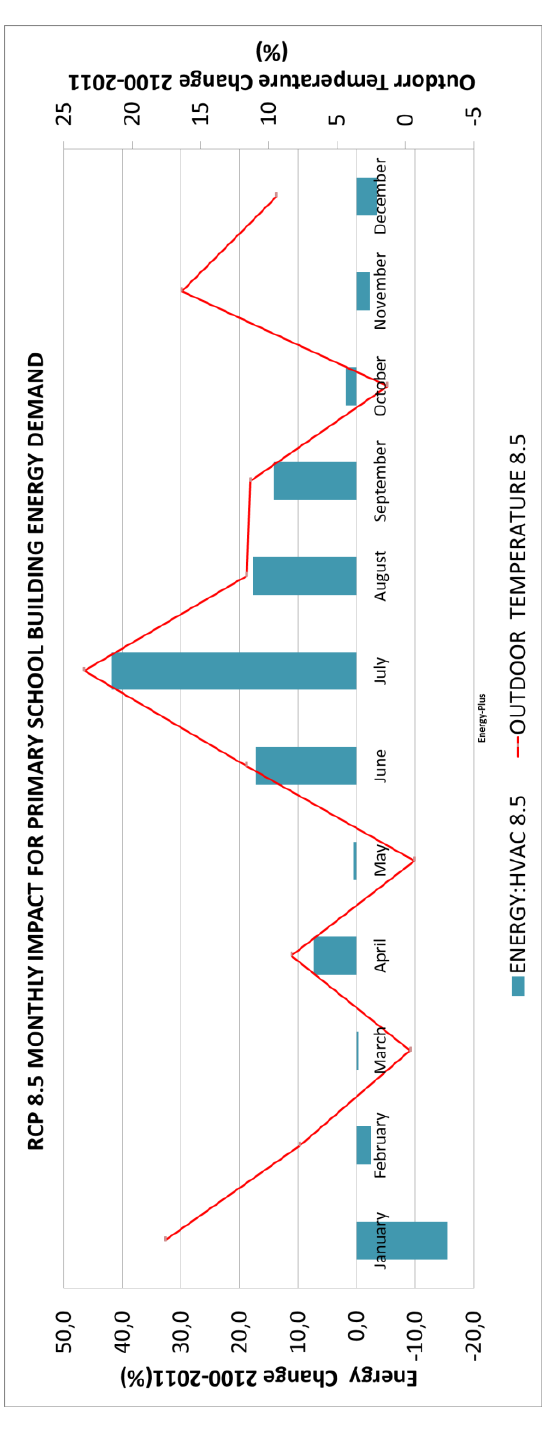
Figure 5: Change 2100-2011 (%) in monthly energy demand (gas and electricity) and outdoor temperature for a prototype primer school building of Madrid with RCP 8.5 climate